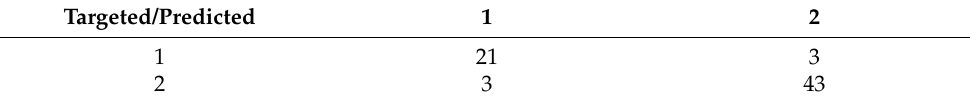
Table 10. The confusion matrix for 3D Resnet152 architecture on the AIRTLab dataset.